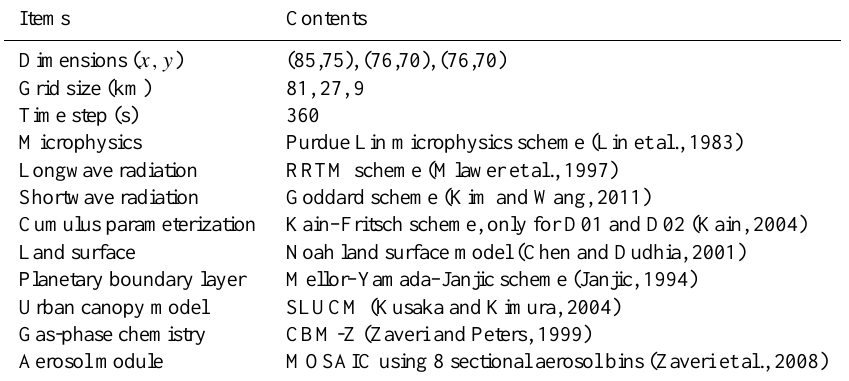
Table 1. The grid settings, physics and chemistry options used in this study for WRF/Chem.